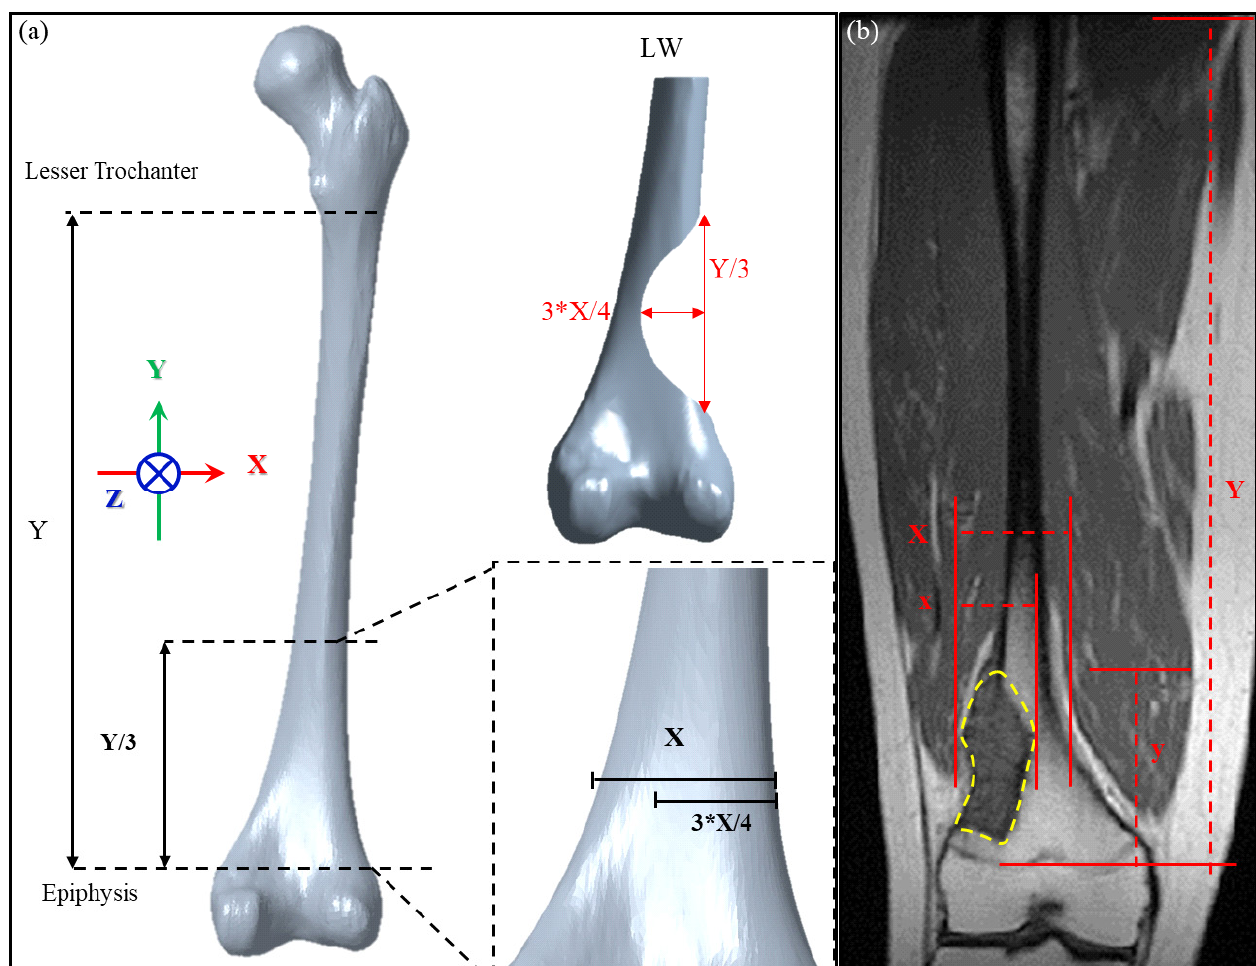
Figure 1. ( a ) Definition of the dimensions of the distal lateral femur defect according to femoral anatomical features; ( b ) application of the definitions to the MRI of a patient with a maximally large distal femur defect.